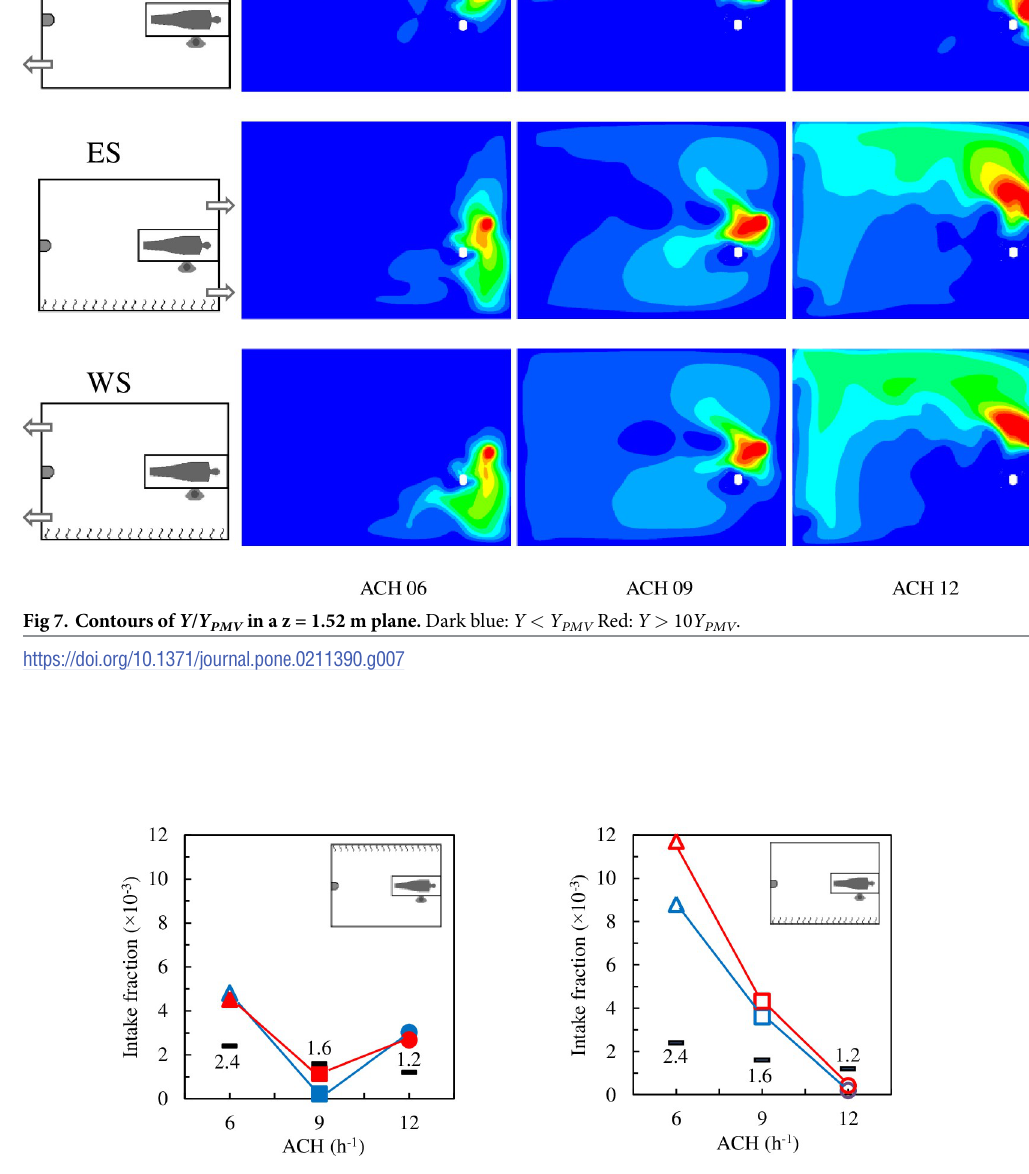
Fig 8. Intake fraction index. Black: IF . Blue symbols: exhaust openings on the wall of the DD, red symbols: PMV exhaust openings on the wall of the bed.